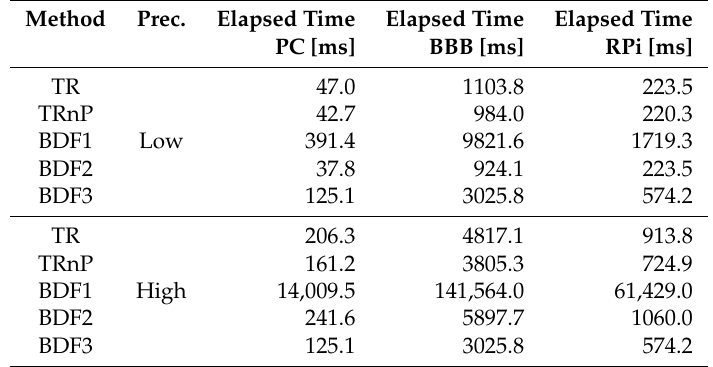
Table 16. Elapsed times in the simulation of the full wave rectifier